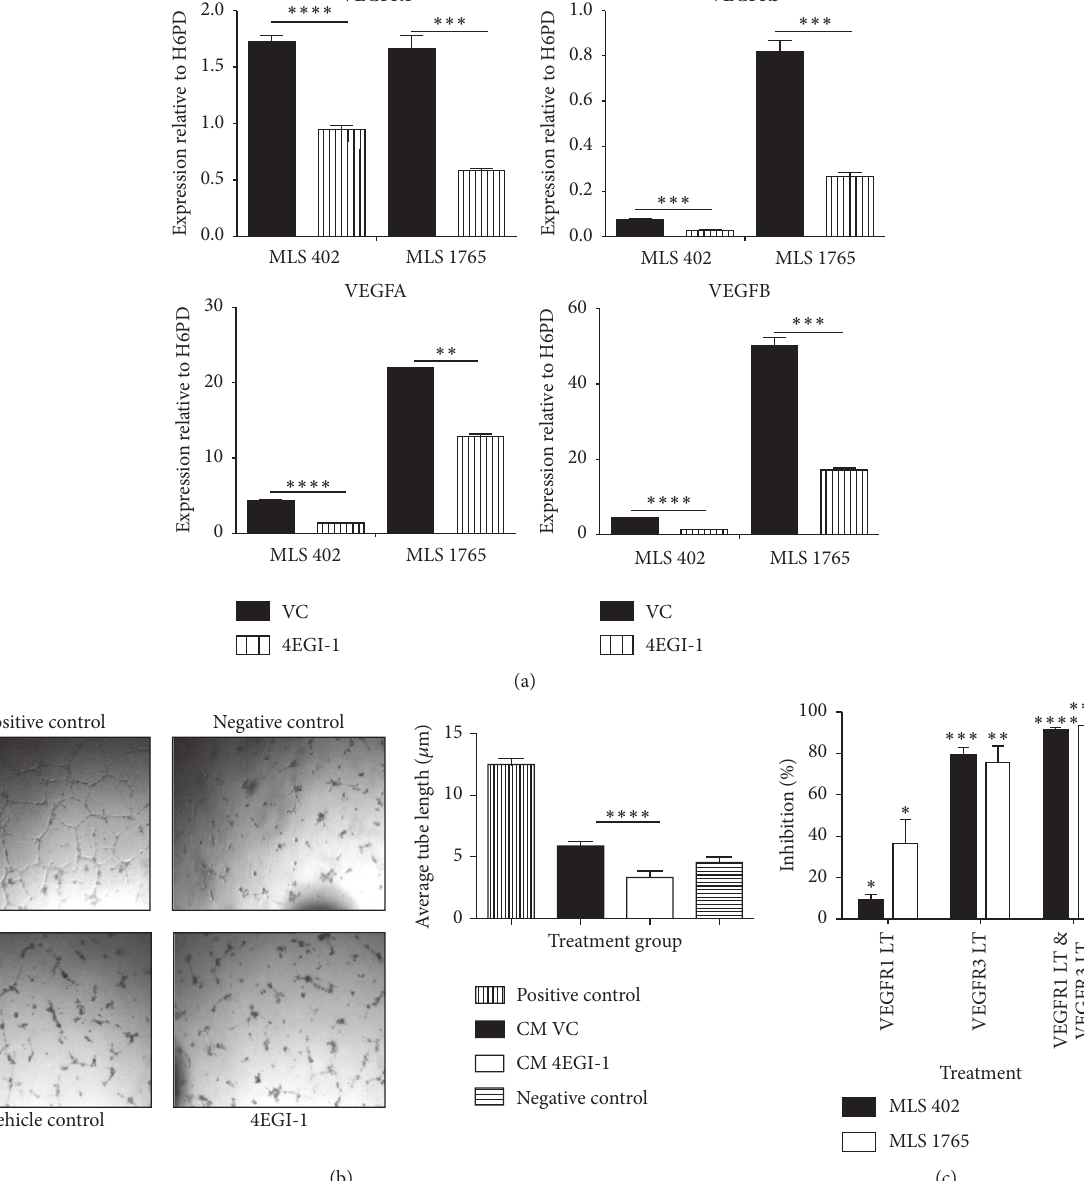
Figure 3: eIF4E promotes angiogenic properties. MLS 402 and MLS 1765 cells were treated with IC 50 4EGI-1 (MLS 402, 8.2 𝜇 M; MLS 1765, 4.8 𝜇 M) or vehicle control (VC) overnight, and then RT-qPCR was performed to measure the expression of VEGF ligands and receptors. The assay was performed three times. The data shown are from three independent experiments presented as mean + SEM relative to the housekeeping gene H6PD (a). HUVECs were suspended in Matrigel, and then conditioned medium from MLS 402 cells pretreated with IC 50 4EGI-1 or vehicle control overnight was applied. Images were acquired at hourly intervals, and the figure displays representative images taken at 8 h. Tube length was measured using ImageJ (version 1.47d) (b). CM, conditioned medium; IB, immunoblotting; LO, Lipofectamine-only treated cells; Ut, untreated MLS cells. MLS 402 and MLS 1765 cells were plated overnight and then treated with 20 𝜇 g/mL VEGFR1 ligand trap (LT), VEGFR3 ligand trap, both ligand traps, or vehicle control for 3 days. Then an MTS dye uptake assay was performed to measure cell viability, and the effect on cell proliferation was calculated (c). Technical duplicates and biological triplicates were tested. A paired, two-tailed 𝑡 -test was performed. The data are presented as mean + SEM. ∗ 𝑝 < 0.05 ; ∗∗ 𝑝 < 0.01 ; ∗∗∗ 𝑝 < 0.001 ; ∗∗∗∗ 𝑝 < 0.0001